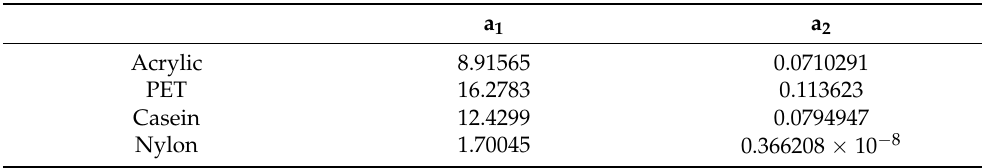
Table 8. Parameters of regression equation by Equation